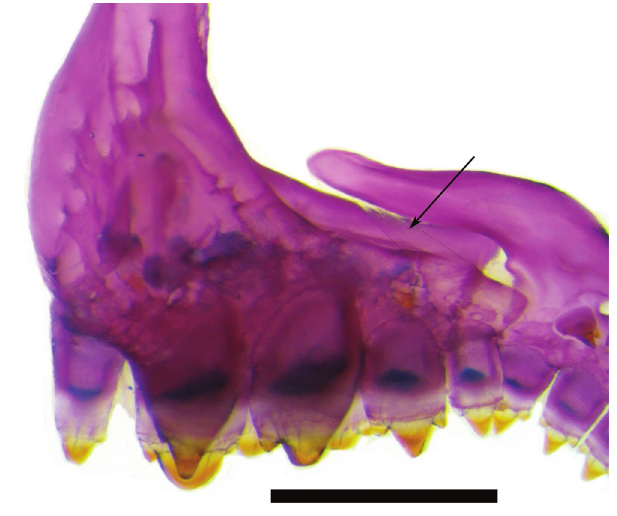
Fig. 6. Premaxilla and part of the maxilla of Carlastyanax aurocaudatus , CI-FML 5015, 44.4 mm SL, medial view, anterior to left. Scale bar = 1 mm. Arrow indicates the ligament between middle length of ascendant maxillary process and the premaxilla, described in the character